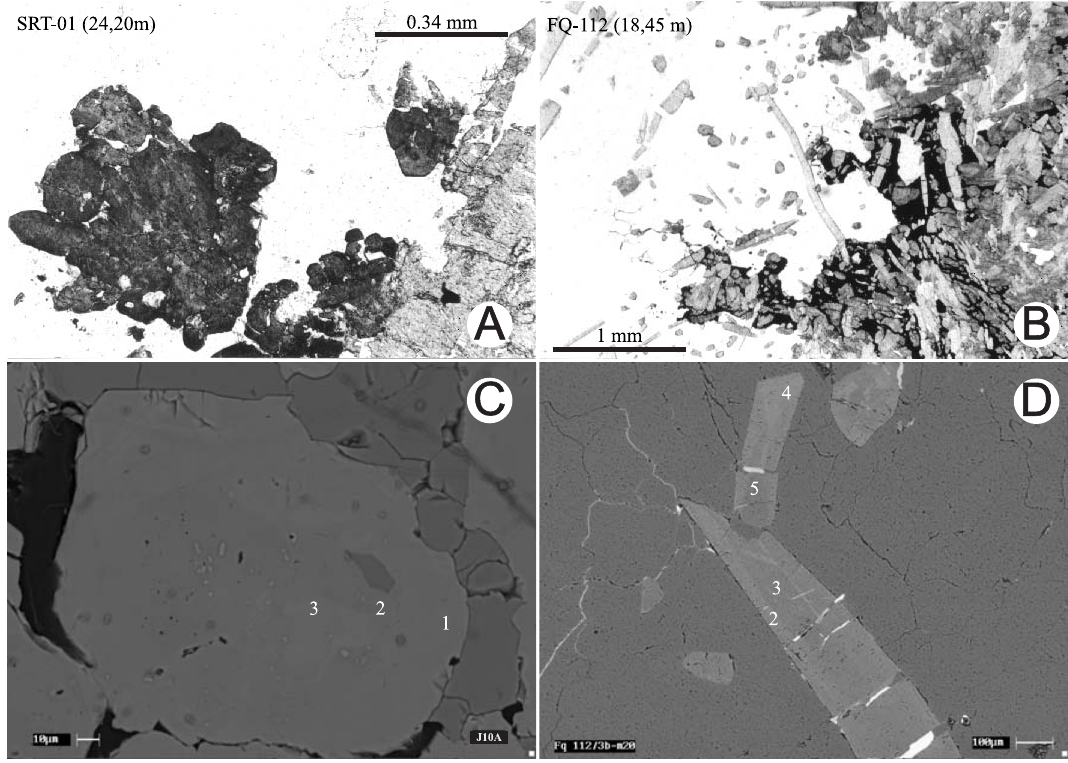
Fig. 2 – B&W photomicrographs ofA: very dark, zoned, strongly pleochroic tourmalines from Tapera Grande metachert (plane-polarized light), and B: zoned tourmaline needles of Quartzito quartz vein (plane-polarized light). SEM images of C: zoned tourmaline crystal from Tapera Grande metachert (to points 1, 2 and 3 correspond analyses 19, 20 and 21 in Table I), and D: zoned tourmaline needles of Quartzito quartz vein, also shown in B (to point 2 correspond analyses 63 and 64; to point 3, analyses 67, 68 and 71; to point 4, analyses 72, 75 and 76, and point 5, analyses 79 and 80 in Table